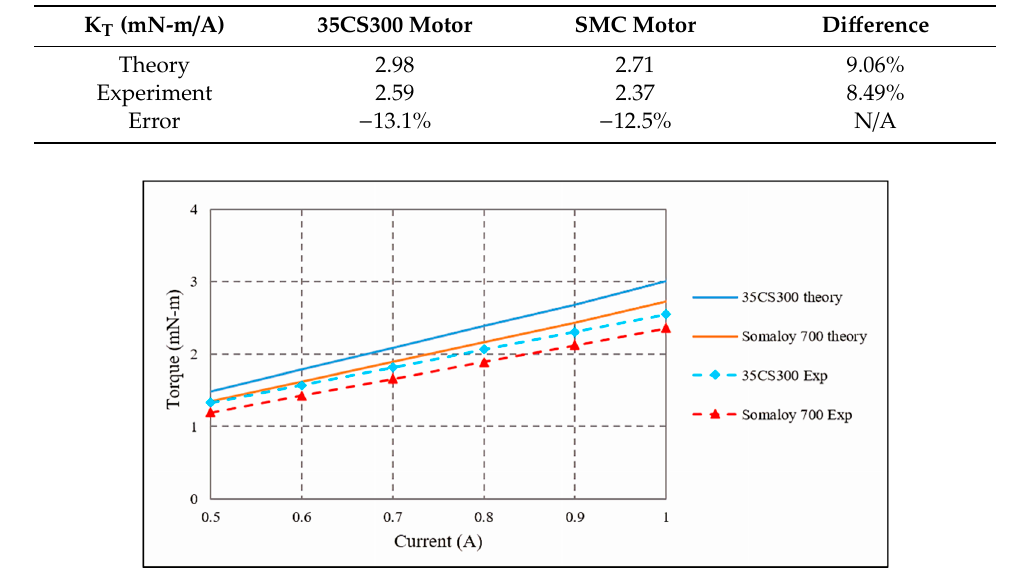
Table 6. Comparison of torque constants (K T ) of 35CS300 and Somaloy 700 1P motors .